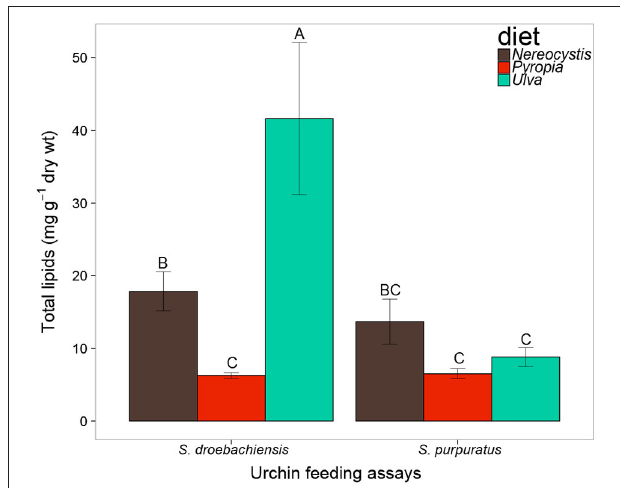
FIGURE 1 | Total lipid (mg g − 1 dry tissue weight) of macroalgae fed to S. droebachiensis and S. purpuratus . Bars with the same letter are not significantly different (2-way ANOVA, Tukey HSD, p < 0.05). Concentrations represent mean ± standard deviation, SD ).